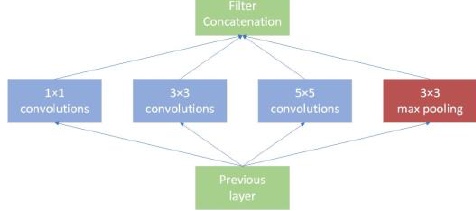
Figure 1. Inception